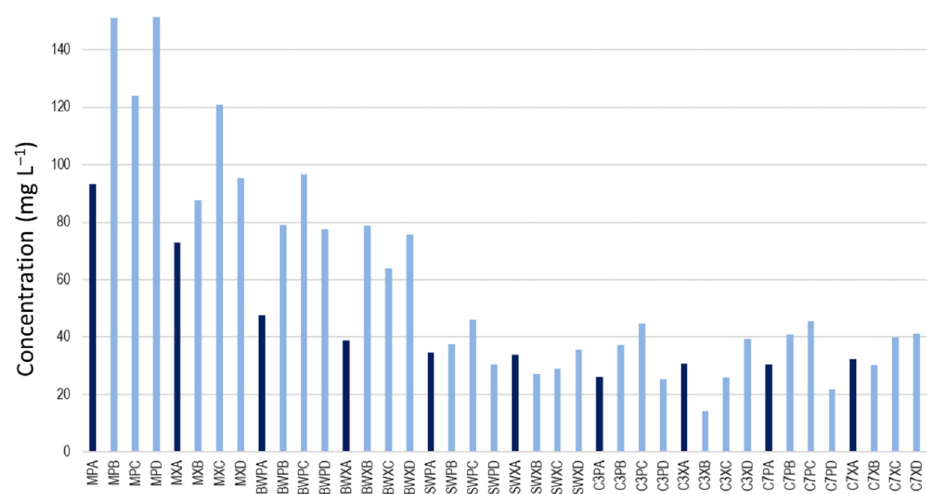
Figure 2. Bar chart of the potassium (K) concentration in the different samples. Quality A for each type of sample has been marked in darker blue to be distinguishable.